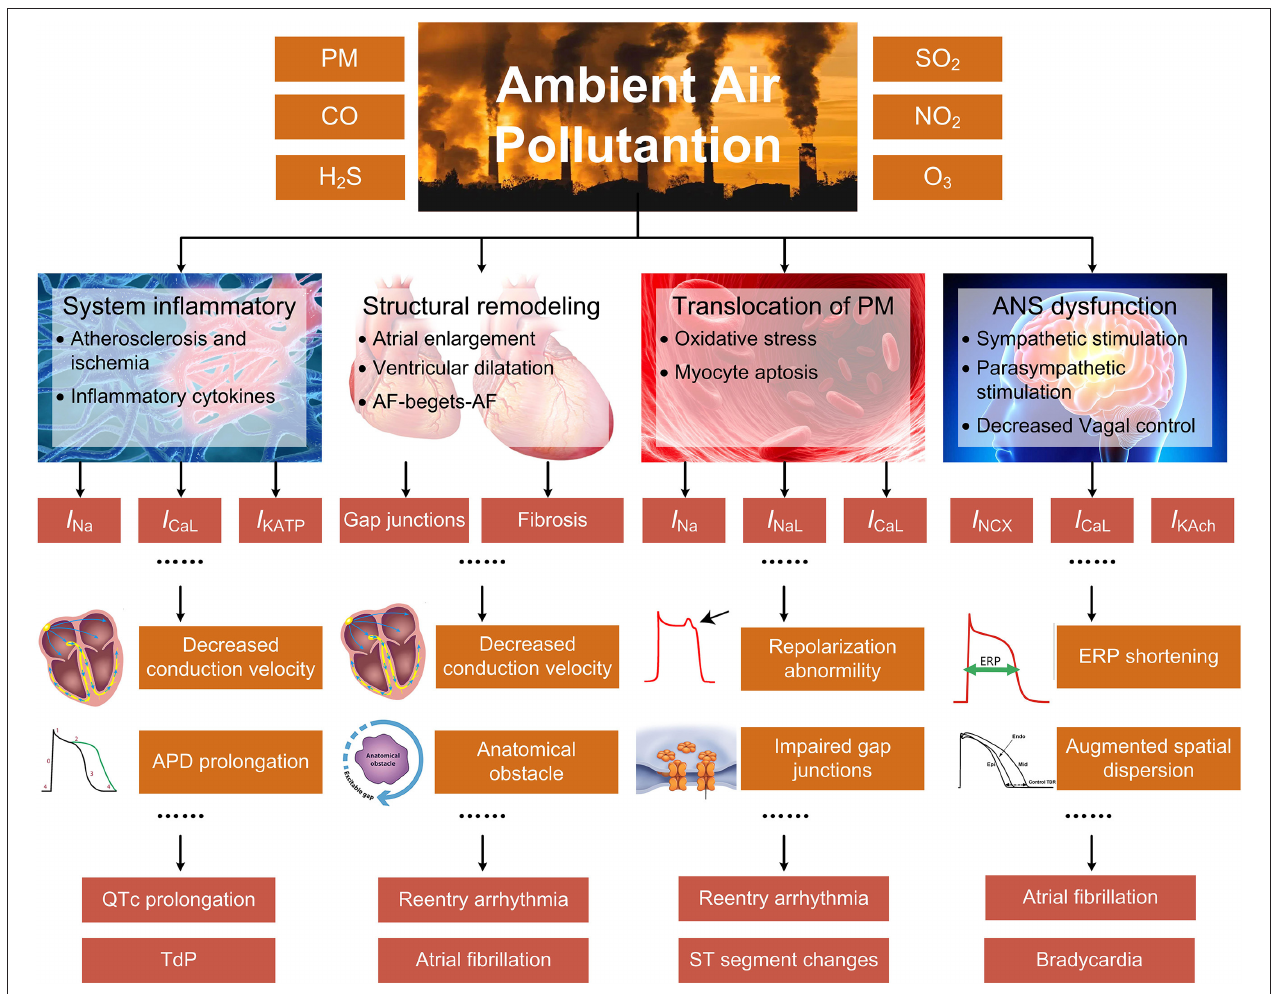
FIGURE 1 | The indirect mechanisms underlying air pollution-induced arrhythmias, including systemic inflammatory response, cardiac structural remodeling, translocation of particles into cardiovascular systems, and ANS dysfunction. The specific pathways are closely linked or overlapped, and only the primary and representative pathways are illustrated for each